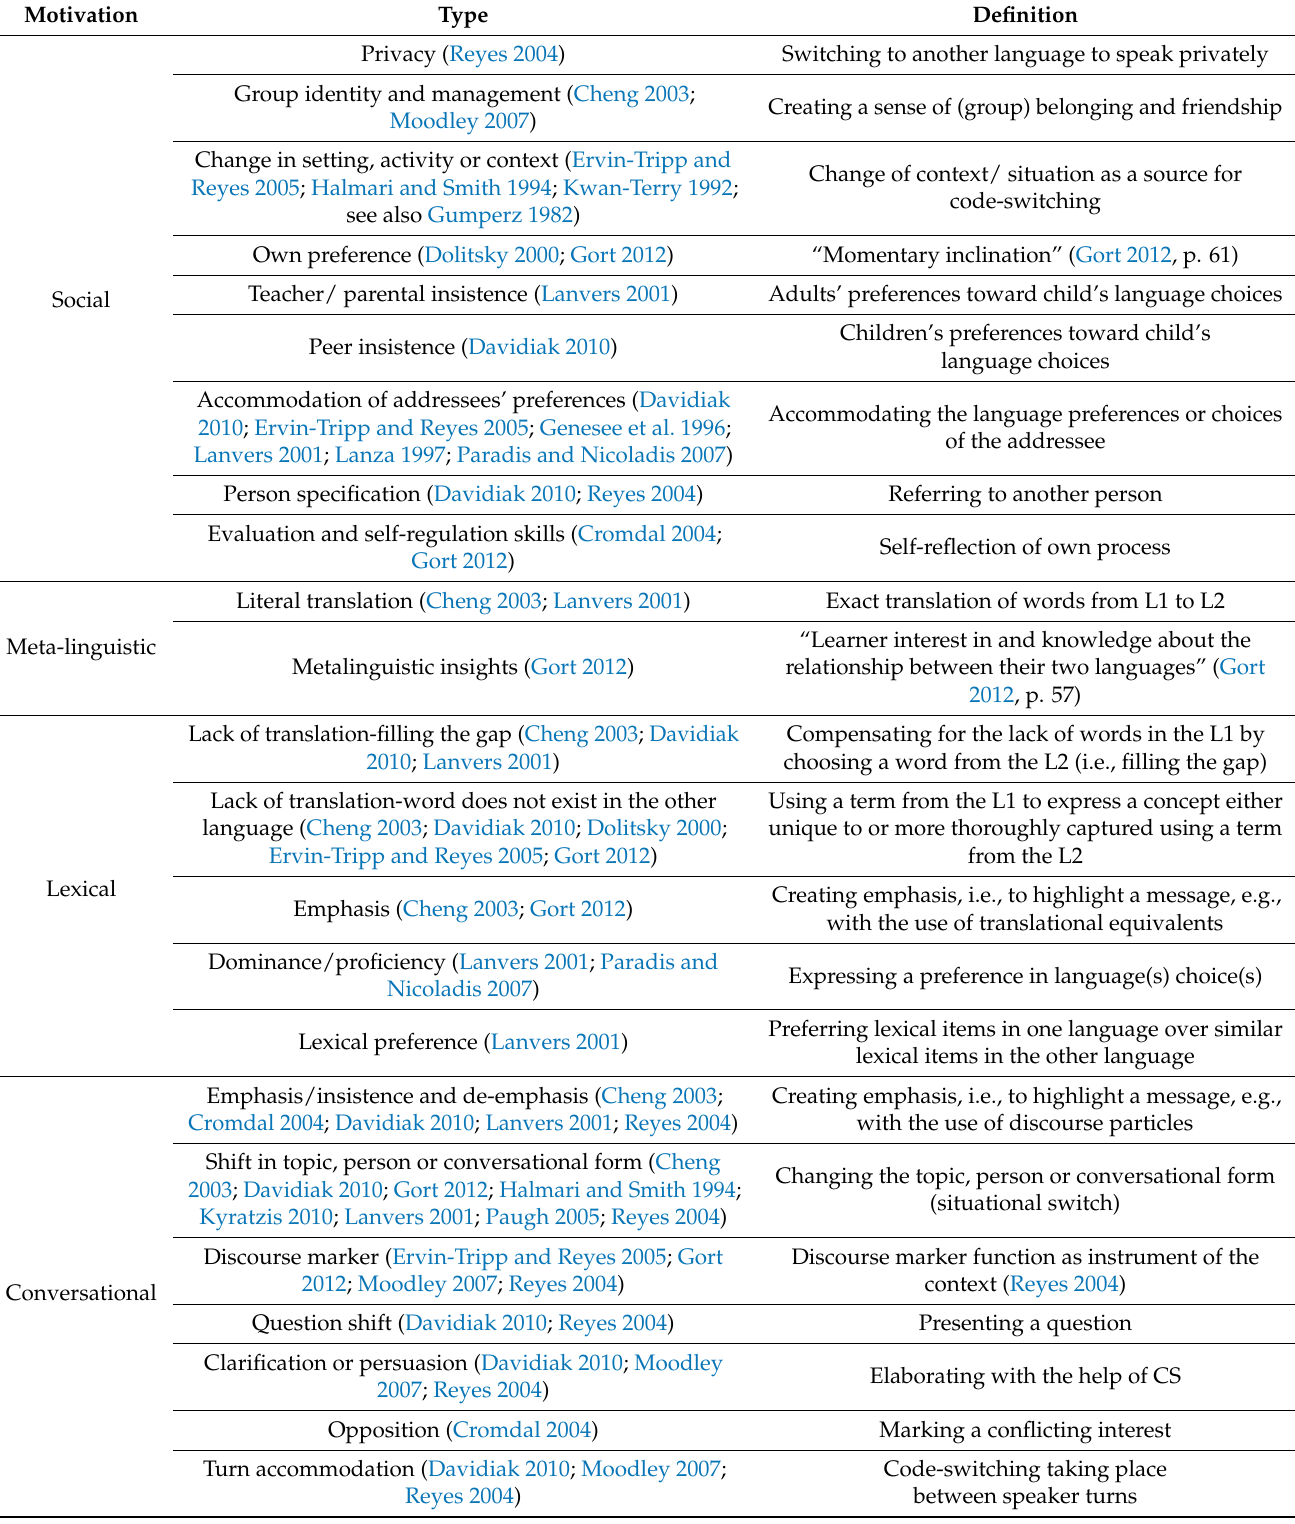
Table 1. Overview of factors underlying code-switching in bilingual children in earlier work